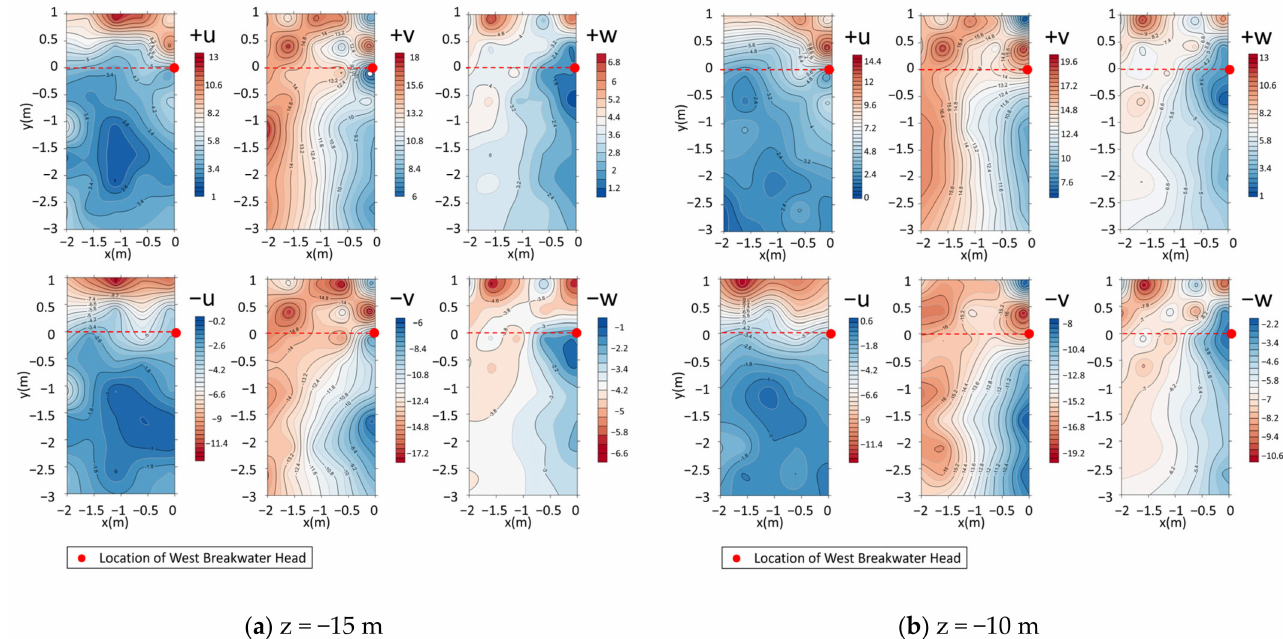
Figure 24. Max u, v, w at west side of the West Breakwaters at z = − 15 m.